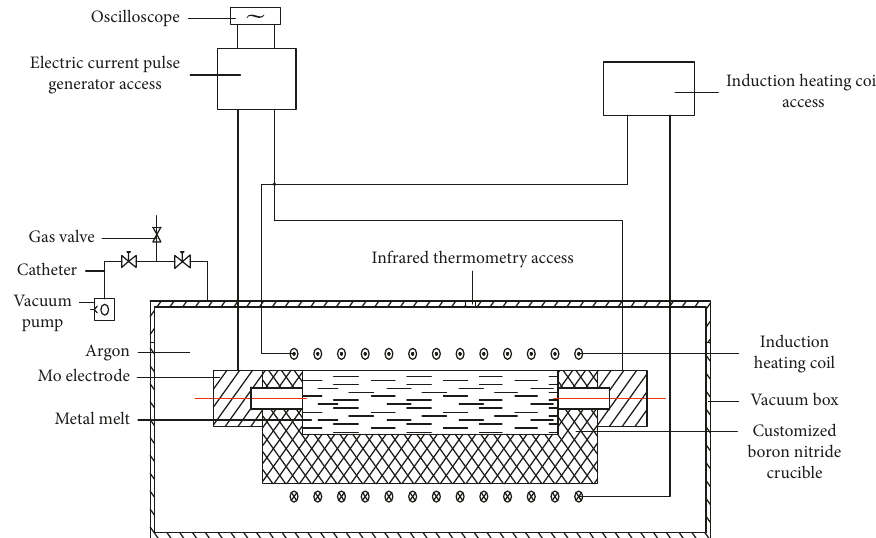
Figure 1: Schematic diagram of the electric pulse melting device.